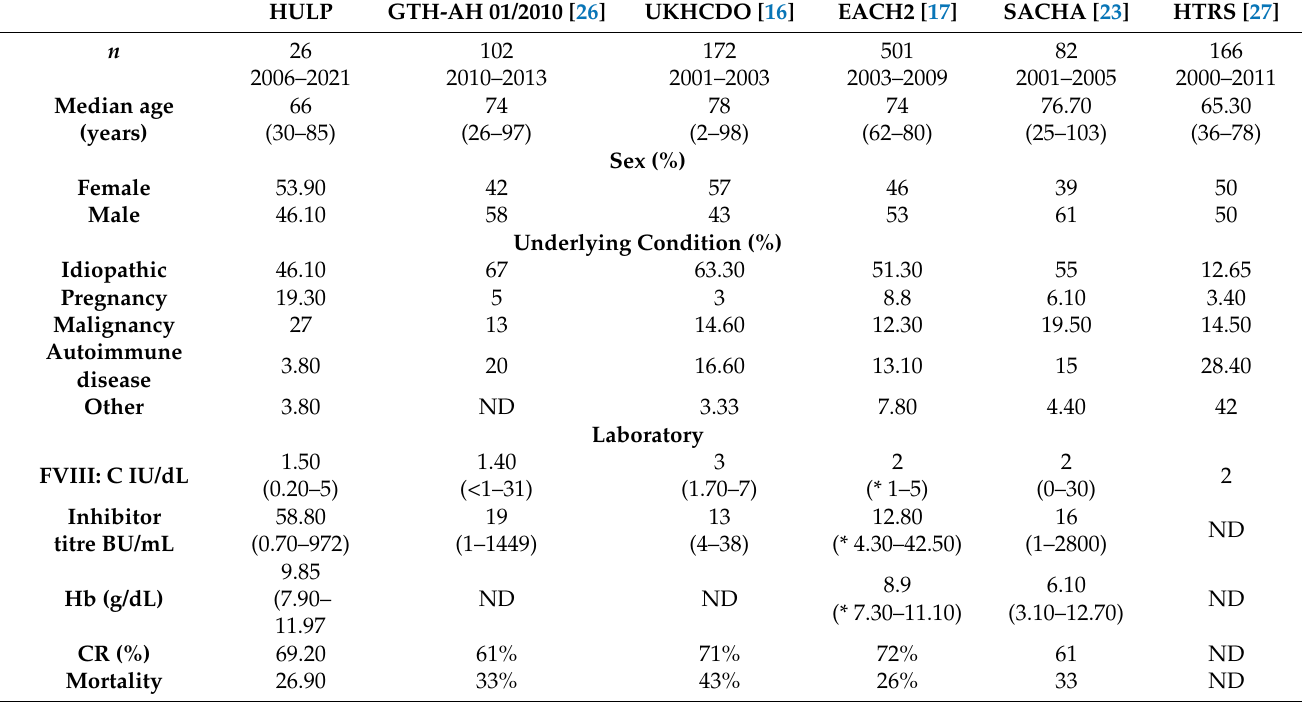
Table 5. Demographic comparison with large patient groups with acquired haemophilia